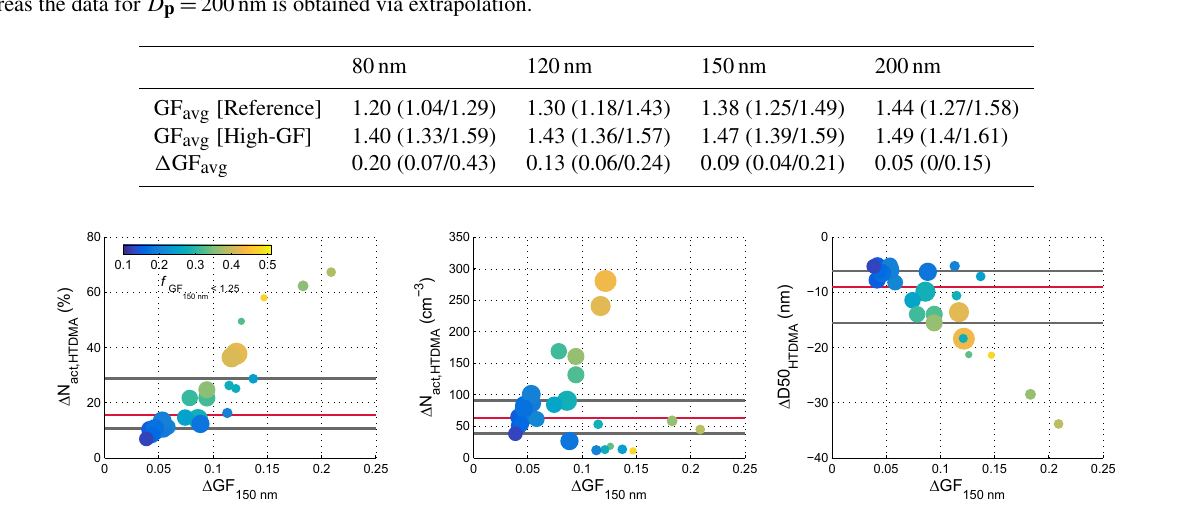
Figure 5. Simulated changes in cloud droplet number concentration ( N act , HTDMA ) and critical activation diameter (D50 HTDMA ) if all the particles belonged to the more hygroscopic mode. The marker size illustrates the total particle concentration in the range of 388cm − 3 to 3316cm − 3 and the data points are colored according to the less hygroscopic fraction (i.e., the fraction of particles merged into the more hygroscopic mode). The horizontal lines correspond to the 25th, 50th and 75th